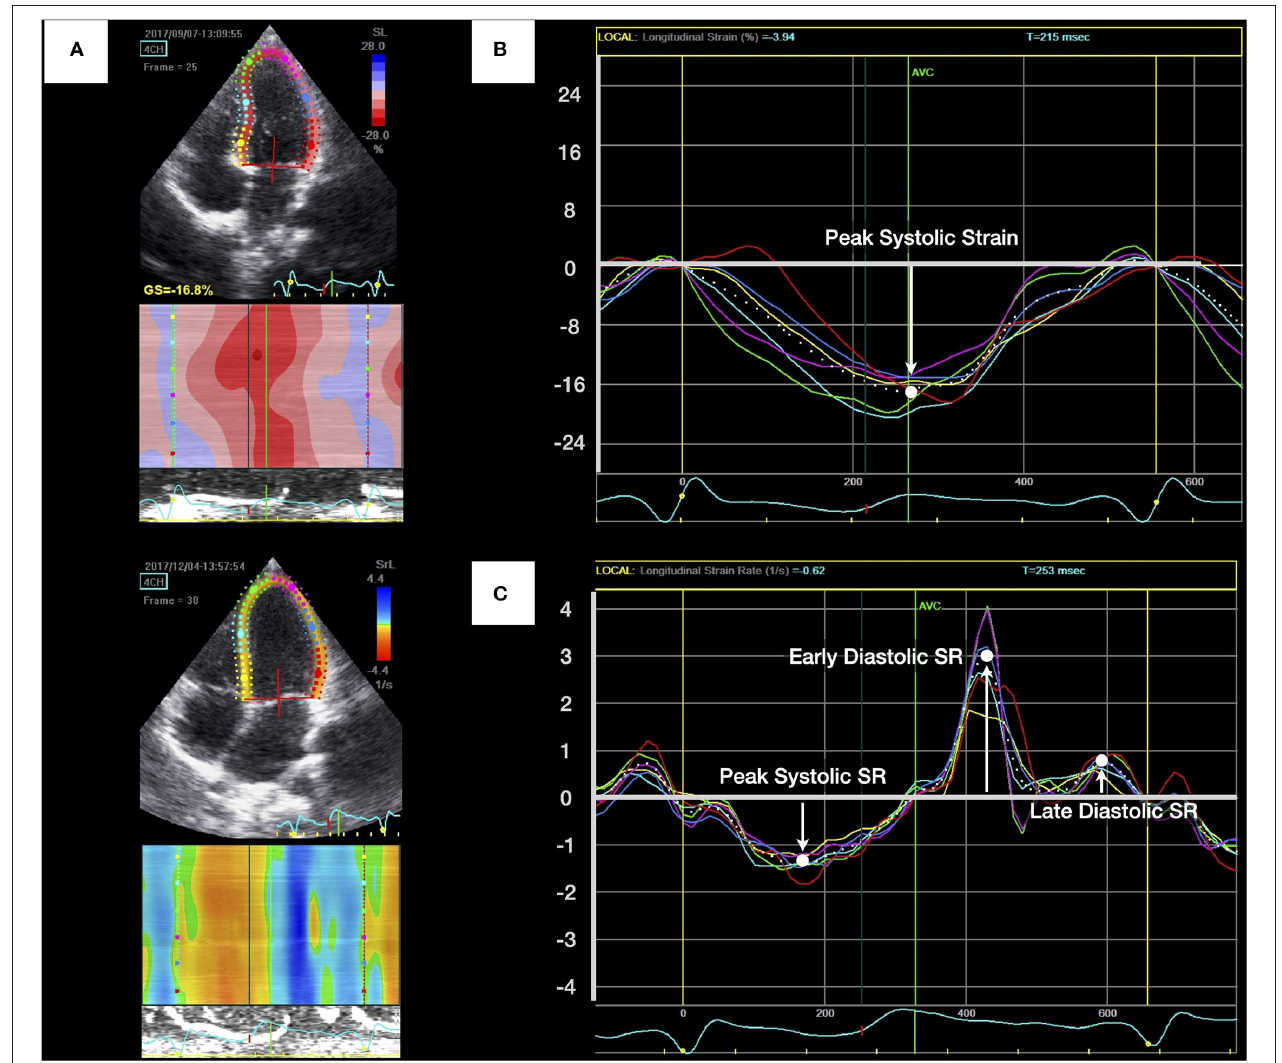
FIGURE 1 | Measurement of left ventricular (LV) longitudinal peak systolic strain and strain rate (SR). (A) Apical four-chamber view of the left ventricle with the region of interest. (B) LV longitudinal peak systolic strain was identified as the highest point and calculated by averaging measurements of six curves. (C) The peak systolic SR, early diastolic SR, and late diastolic SR were generated from LV apical four-chamber